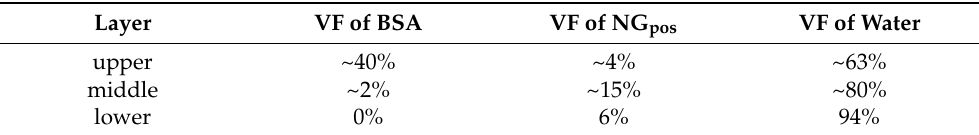
Table 2. Volume fraction (VF) of BSA-NG pos mixtures at air/water interface.